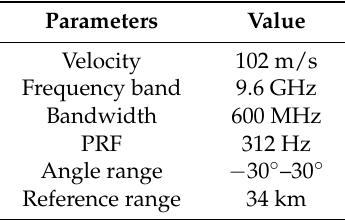
Table 1. Parameters of the system.